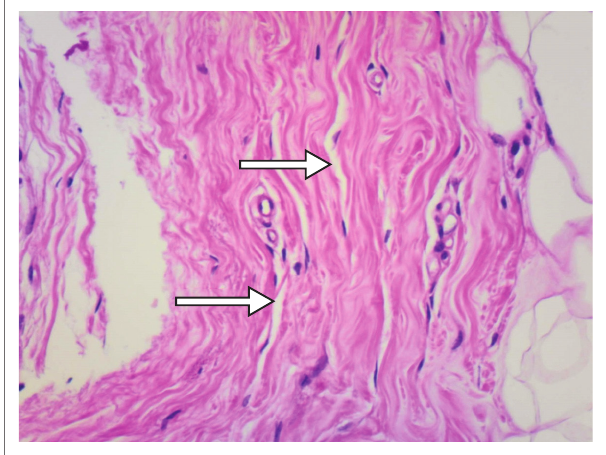
FIGURE 2: Arrows indicate the pseudovascular